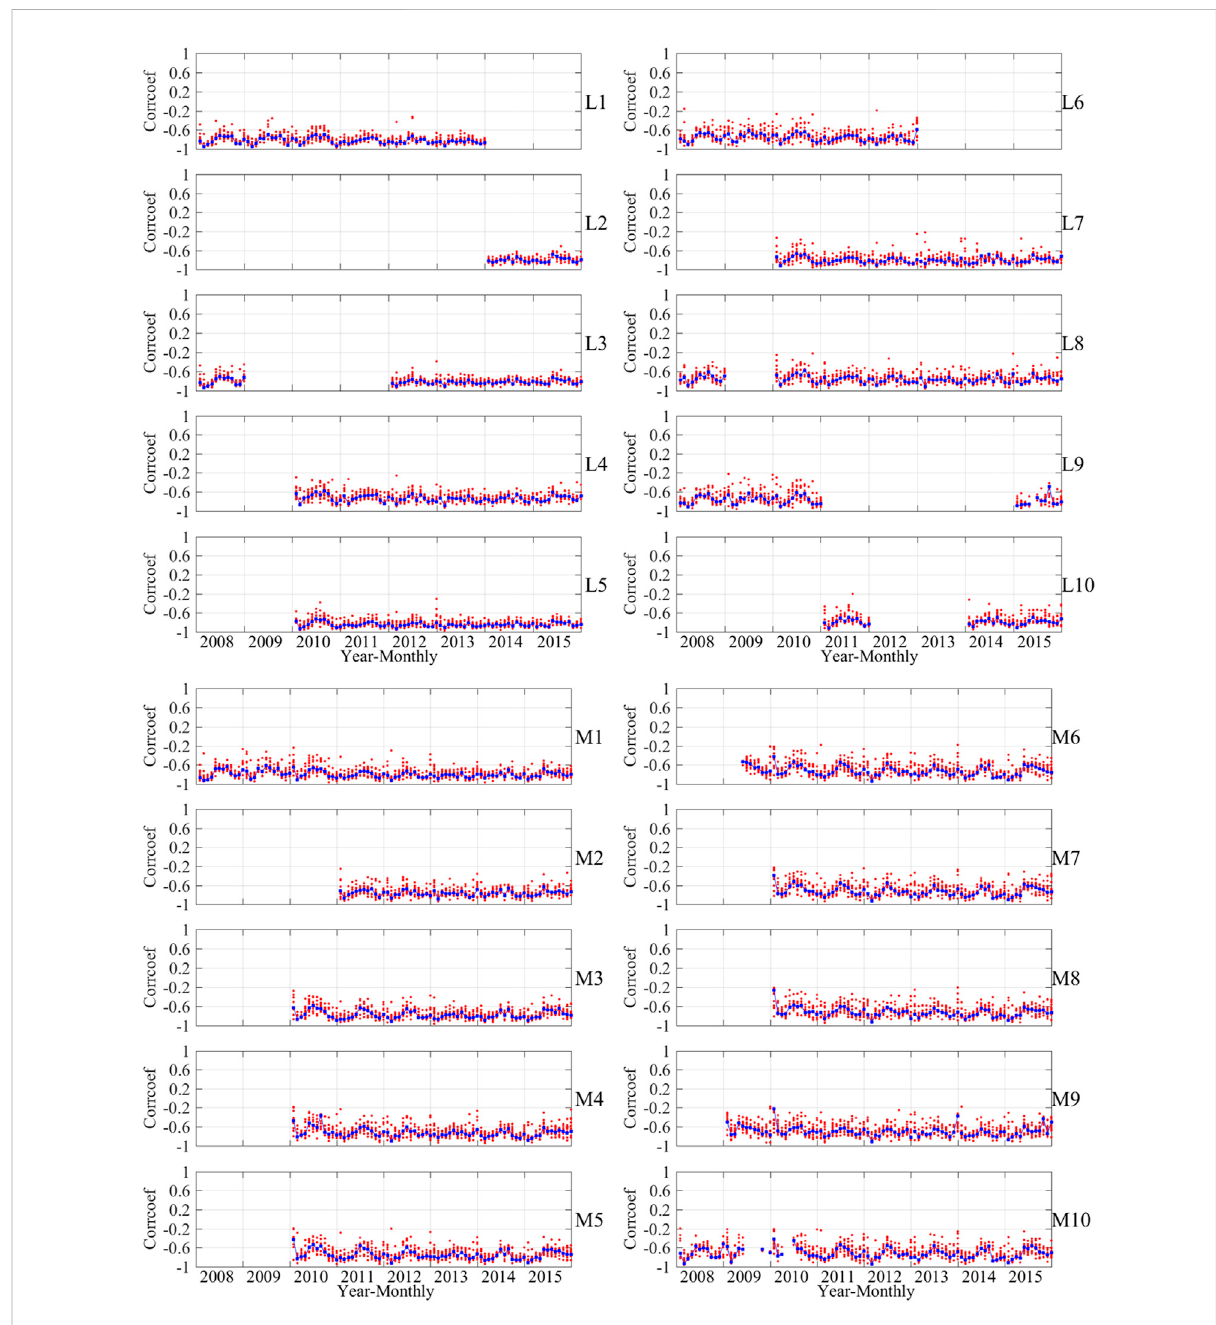
FIGURE 3 Minimum correlation coef fi cients of dqZ and dqTEC (indicated by red dots) and SqZ and SqTEC (indicated by blue dotted